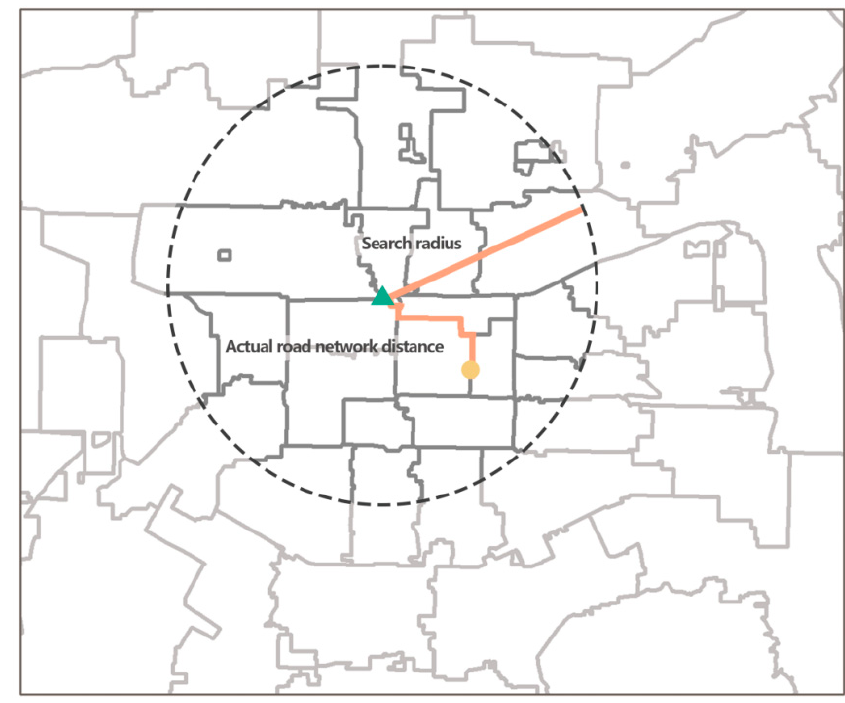
Figure 6. Buffer